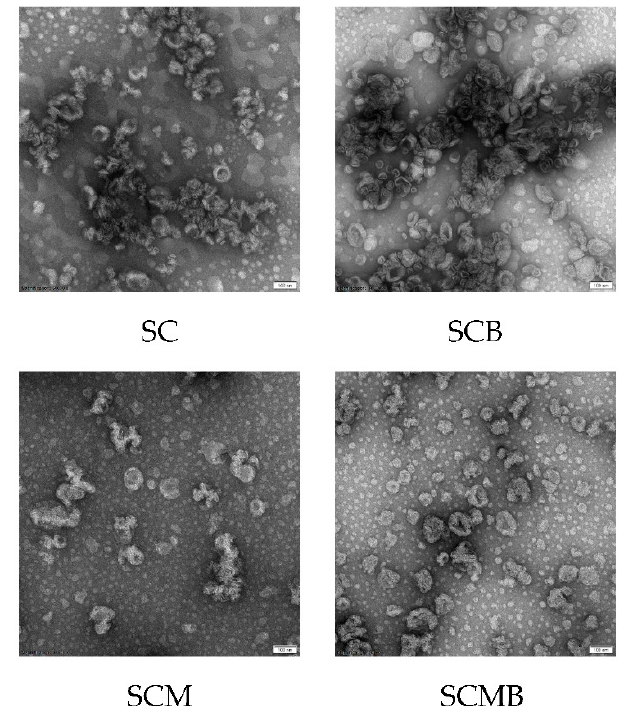
Figure 5. The TEM observation of SC, SCB, SCM and SCMB liposomes (The scales are 100 nm).